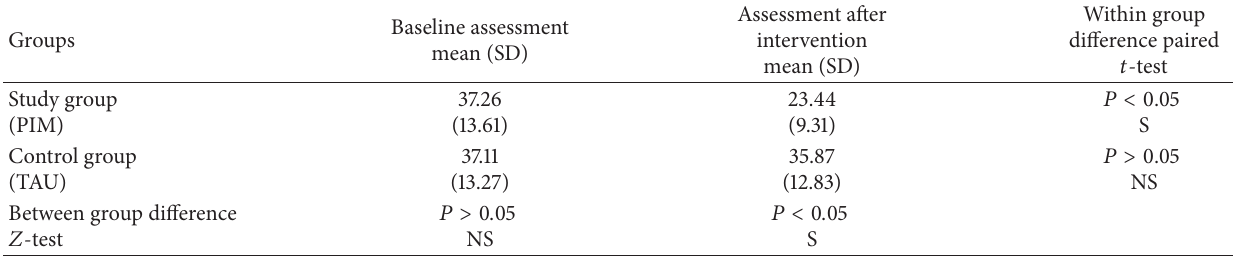
Table 6: Impact of event scale before and after psychological